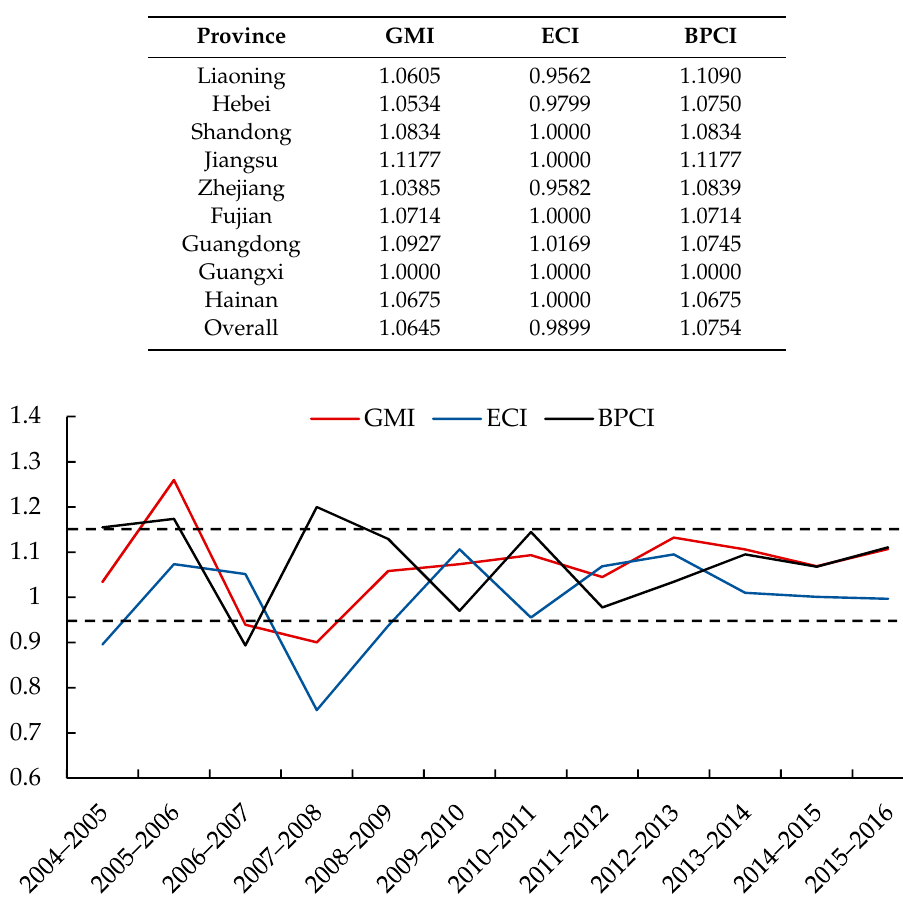
ffi ciency in China,